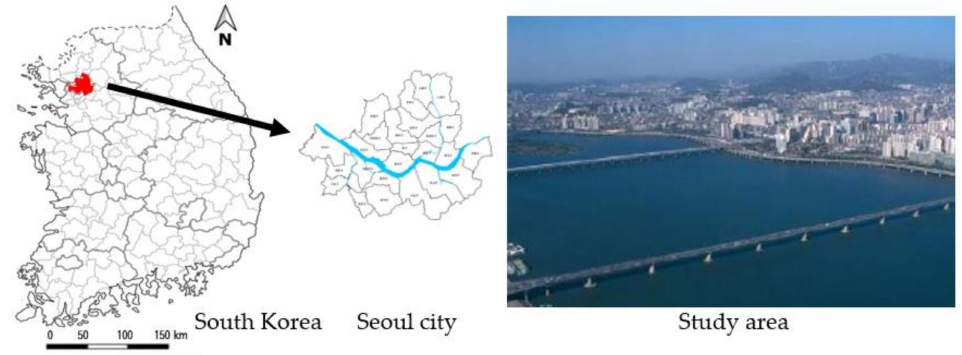
Figure 1. The research site’s location and landscape.